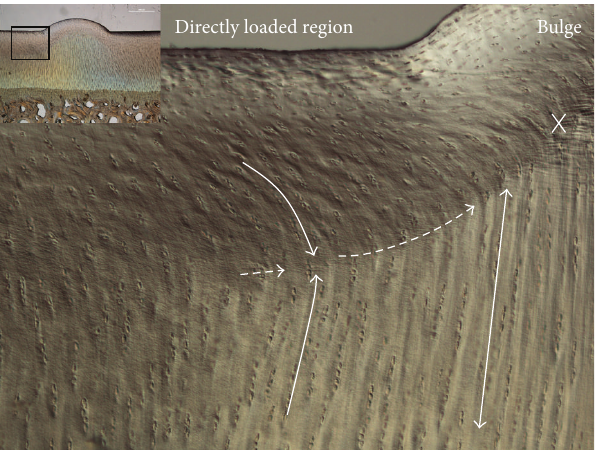
Figure 10: A high magnification image of the region indicated in Figure 9. The wavy lines show the in-phase fibrillar paths. Note the increasingly acute and fine packing moving towards the left. The arrows are drawn by connecting the “peaks and troughs” of the wavy line traces and give an indication of the overall shear direction. DIC imaging.